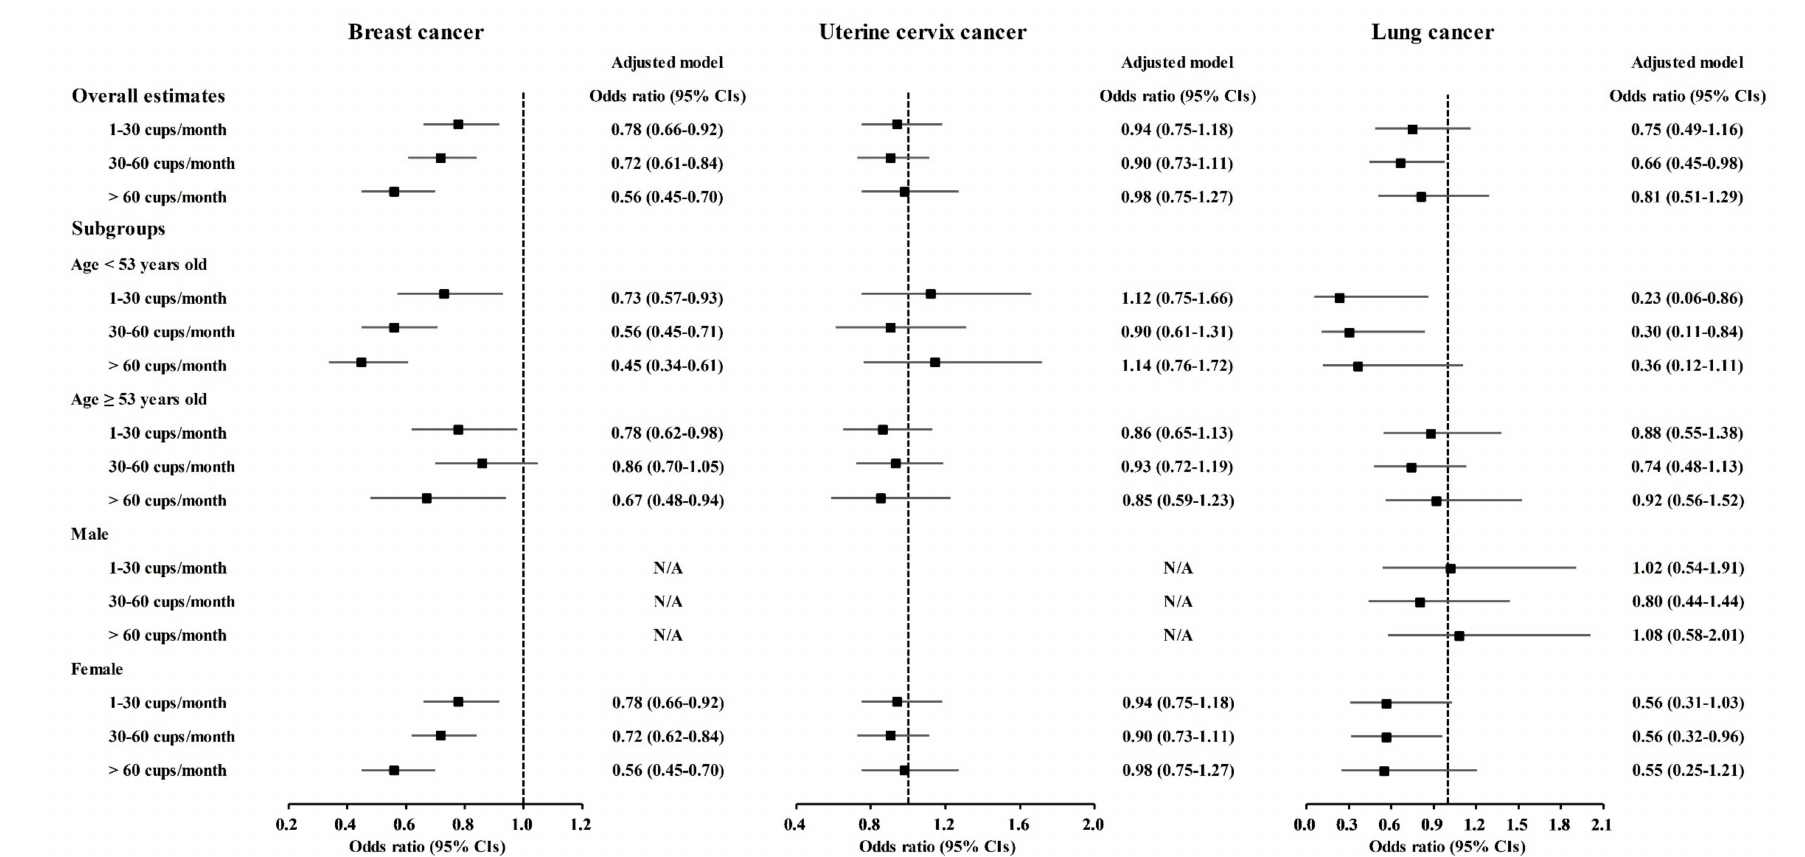
Figure 3. Odds ratios of coffee drinking habit for breast cancer, uterine cervix cancer, and lung cancer histories according to age and